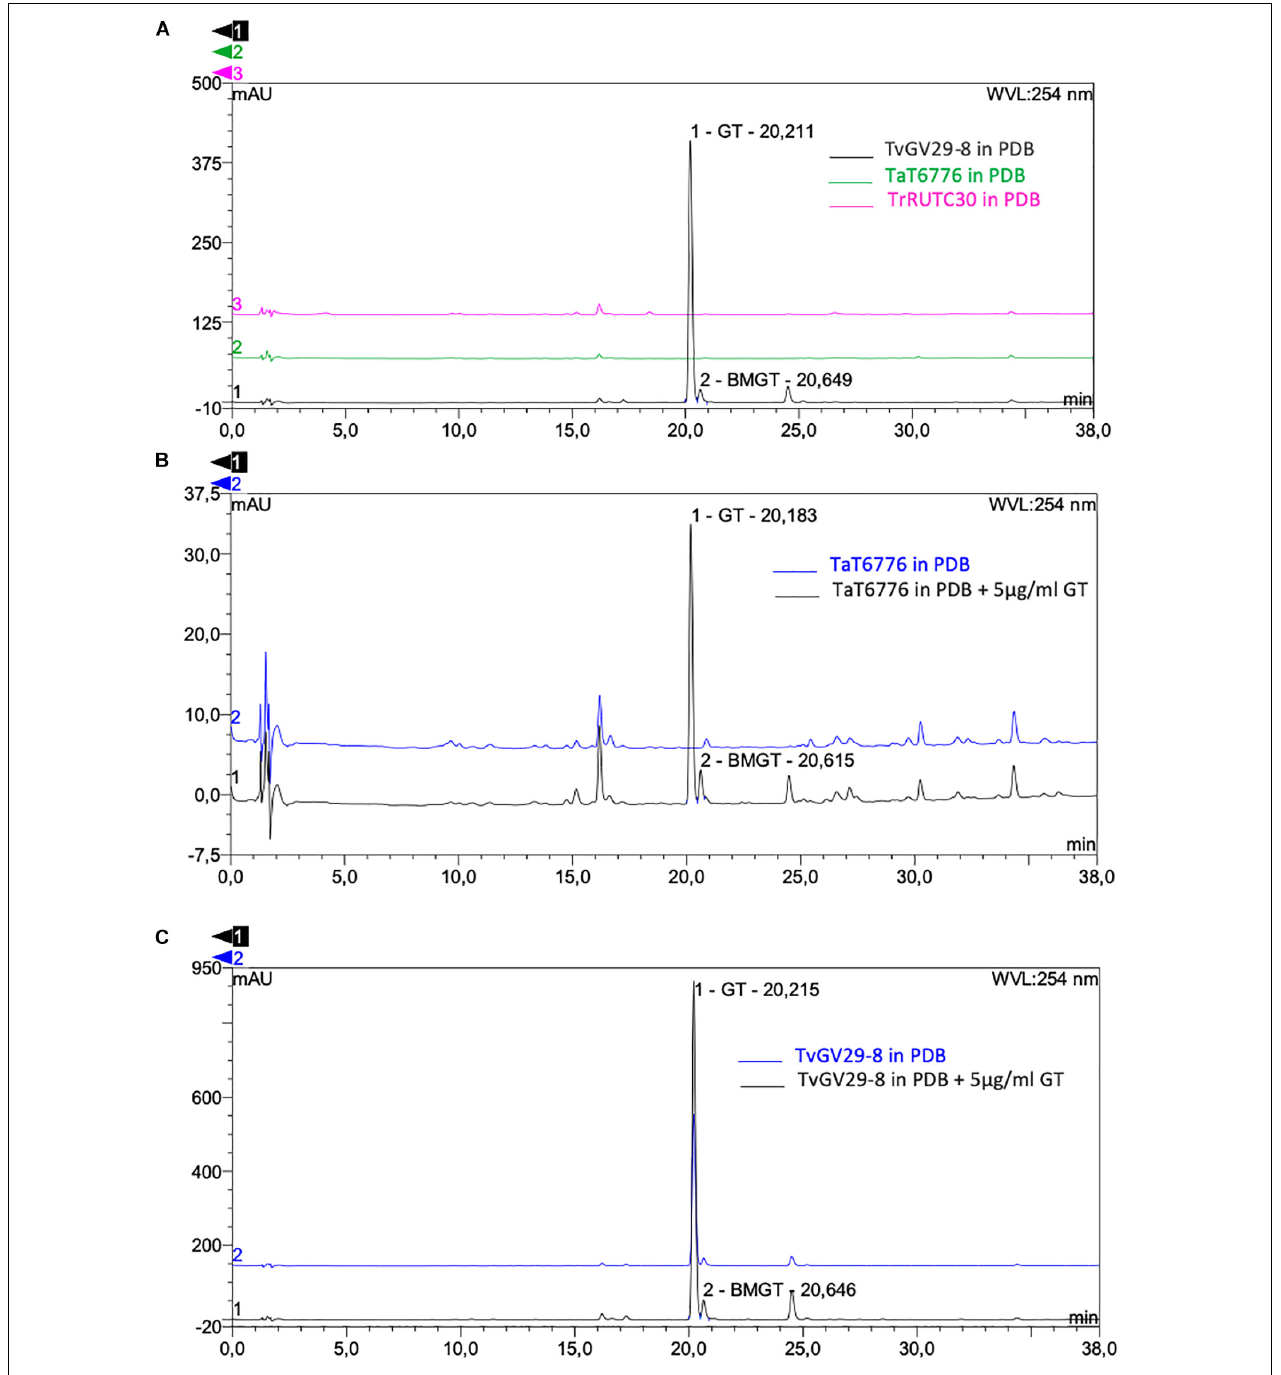
FIGURE 4 | High-performance liquid chromatography (HPLC) detection of gliotoxin (GT) and bis (methyl)gliotoxin (BmGT) in fungal culture filtrates. (A) Comparison between TvGv29-8 (black), TaT6776 (green), and TrRUTC30 (magenta). The chromatograms show the presence of GT and BmGT only in TvGv29-8 sample (black). HPLC detection of gliotoxin (GT) and bis (methyl)gliotoxin (BmGT) in culture filtrates after 27 h incubation time of (B) TaT6776 and (C) TvGv29-8, grown in potato dextrose broth (PDB) (blue) and in PDB amended with 5 µ g/ml of GT (dark gray). HPLC analysis was performed in four technical